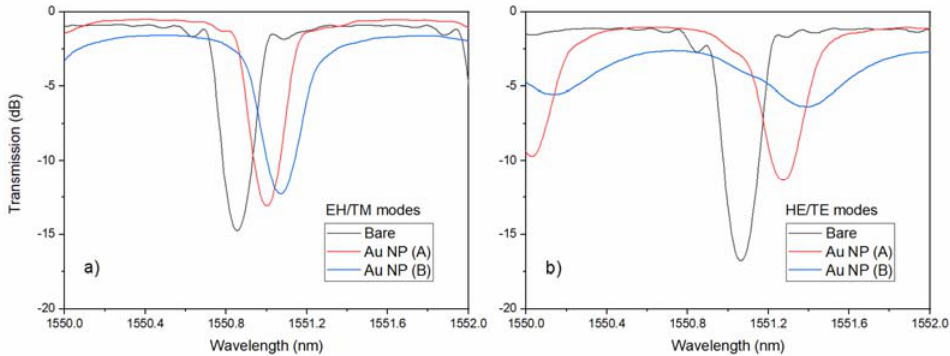
Figure 8. Differences in the ( a ) P-polarized and ( b ) S-polarized cladding mode resonances between a bare TFBG and two others with different gold coatings deposited by electroless plating: coatings A and B have similar thicknesses near 28 nm, but coating A was deposited faster (4.6 vs. 7.25 min).